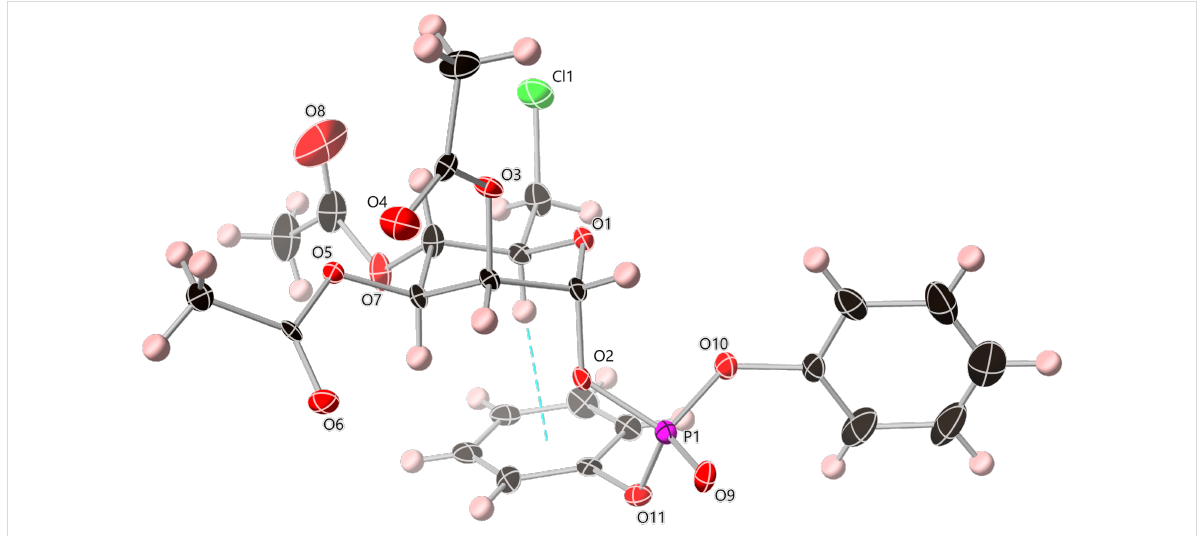
Figure 2: Structure of 16 with ADPs rendered at the 50% probability level. Acetyl group disorder is omitted for clarity. Atom colour scheme: carbon = black, oxygen = red, phosphorus = purple, chlorine = green, hydrogen = pink. C6–Cl is the gg rotamer (from the Cl6–C6–C5–O5 torsion angle).